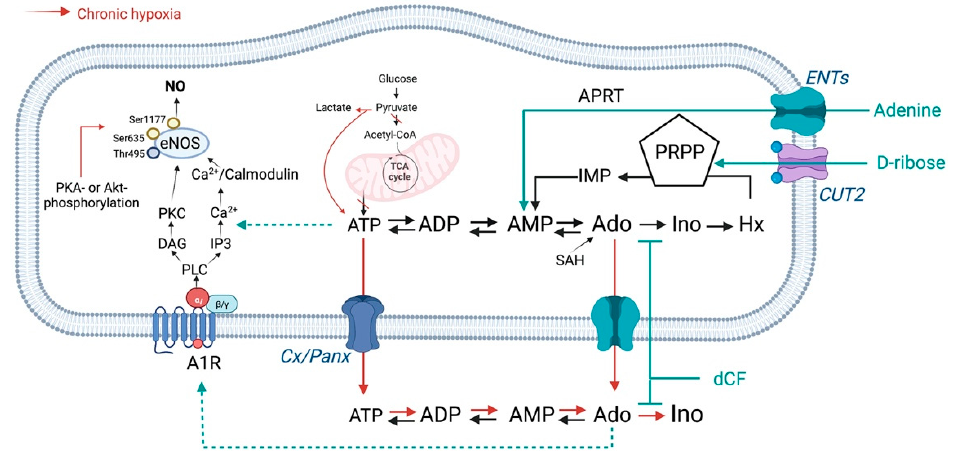
Figure 8. Pathways of nucleotide and adenosine metabolism in endothelial cells under hypoxia. The addition of adenine with ribose promotes both synthesis of adenine nucleotides and adenosine production, while 2 ′ deoxycoformycin (dCF), decreasing adenosine to inosine catabolism inside and outside the cells, enhances the effect on adenosine receptor signaling. ATP, adenosine triphosphate; ADP, adenosine diphosphate; AMP, adenosine monophosphate; Ado, adenosine; Ino, inosine; Hx, hypoxanthine; APRT, adenine phosphoribosyltransferase; IMP, inosine monophosphate; PRPP, phosphoribosylpyrophosphate; SAH, S-adenosylhomocysteine hydrolase; Rib-1P, ribose-1-phosphate; A1R, adenosine A1 receptor; ENTs, equilibrative nucleoside transporters, CUT2, carbohydrate uptake transporter-2; Cx, connexins; Panx, pannexins; TCA cycle, tricarboxylic acid cycle; PLC, phospholipase C; IP3, inositol 1,4,5-trisphosphate; DAG, diacylglycerol; PKC, phosphokinase C; NO, nitric oxide; PKA, protein kinase A; Akt, serine/threonine protein kinase Akt. Created with BioRender.com (Accessed on 27 June 2022).